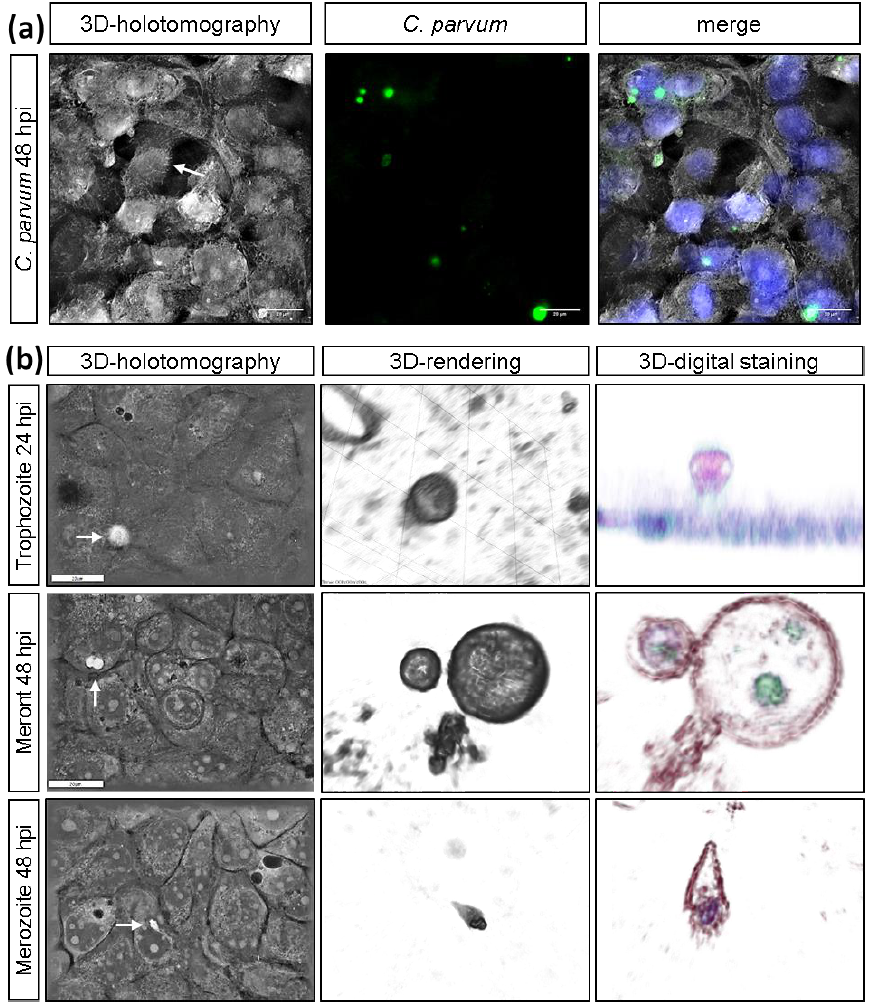
Figure 1. 3D-holotomographic illustration of C. parvum -infected HCT-8. ( a ) C. parvum -infected HCT- 8 cells were stained by biotinylated VVL and Hoechst 33,258 at 24 and 48 h p. i. ( n = 3): ( a ) 3D-holotomographic images were obtained by using 3D Cell Explorer microscope (Nanolive) at 60× magnification (λ = 520 nm, sample exposure 0.2 mW/mm 2 ) and a depth of field of 30 µm. ( b ) Holotomography of C. parvum -infected HCT-8 and identification of trophozoite, meront and merozoite stages (Scale bar = 20 µm).